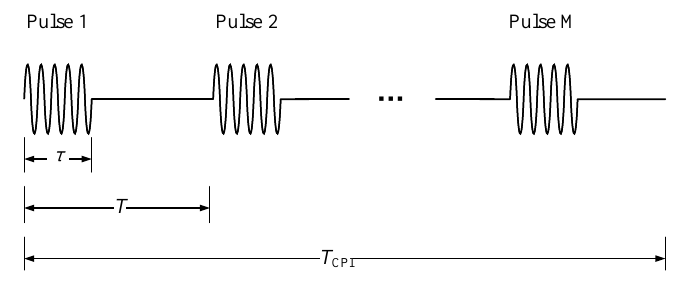
Figure 3. The designed modulated pulses. Table 1. System parameters setting and